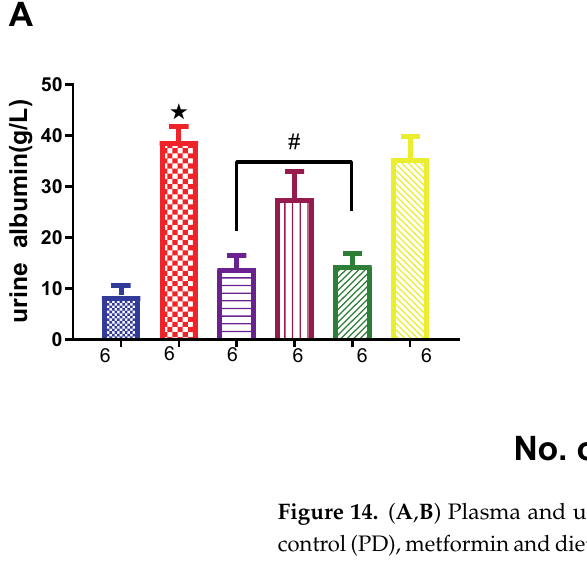
Figure 14. ( A , B ) Plasma and urinary albumin concentrations in normal control (NC), prediabetic control (PD), metformin and diet intervention (MET + DI), metformin and high-fat/high-carbohy- drate diet (MET + HFHC), rhenium (V) compound and diet intervention (Re + DI) and rhenium (V) compound and high-fat/high-carbohydrate diet (Re + HFHC) groups after 12 weeks of treatment. Values are presented as means ± SEM (n = 6).